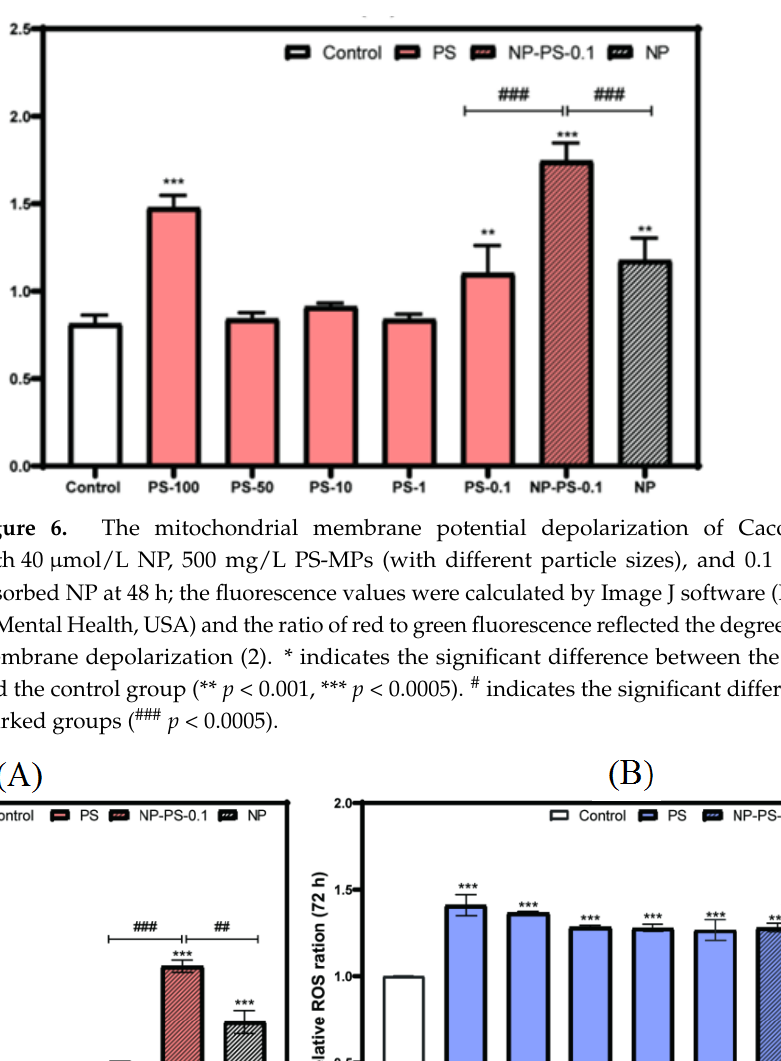
Figure 6. The mitochondrial membrane potential depolarization of Caco-2 cells treated with 40 μmol/L NP, 500 mg/L PS-MPs (with different particle sizes), and 0.1 μm PS-MPs that absorbed NP at 48 h; the fluorescence values were calculated by Image J software (National Institute of Mental Health, USA) and the ratio of red to green fluorescence reflected the degree of mitochondrial mem- brane depolarization (2). * indicates the significant difference between the treatment group and the control group (** p < 0.001, *** p < 0.0005). # indicates the significant difference between the marked groups ( ### p < 0.0005).